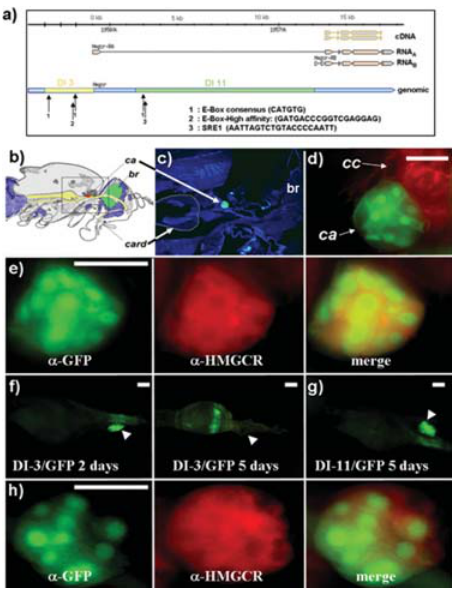
Figure 3. Genesis and expression pattern of the two transgenic p[hmgcr-GAL4] lines. a) Promoters and genomic regions of hmgcr gene. Two mRNAs are transcribed (mRNA A and mRNA B ) under the control of two distinct promoter regions. After splicing, the encoding regions of the two cDNA are identical. A computer analysis of the genomic DNA region has allowed to find two E-Box consensus sequences (CATGTG) [63] localized at 2 3194 to 2 3188 and 2 1315 to 2 1309, and one E-Box High affinity (GATGACCCGGTCGAGGAG) [64] localized at 2 2051 to 2 2033, comprised in a region of 3,8 kb just upstream of the first exon of hmgcr . We then hypothesized that this region could control the RNA A transcription, and cloned and used it to generate the p[DI-3-GAL4] (DI-3) line. To generate the p[DI-11-GAL4] (DI-11) line, we cloned a fragment of 10,6 kb of the first intron ( + 2733 to + 13525) in which we found an E-box consensus [63] ( + 2911 to + 2916) and one SRE1 (AATTAGTCTGTACCCCAATT) [64] ( + 3551 to + 3570). We hypothesized that this region could control the RNA B transcription. b) Schematic lateral view of the head and thorax of Drosophila . card: cardia ; ca : corpus allatum ; br: brain. c–h) The two p[DI-GAL4] lines (DI-3 and DI-11) drive the expression of GFP in the ca . c) At low magnification (10X), the ca , in green, is detected by using primary antibodies against GFP and secondary antibodies labeled with FITC (green) in flies DI-3/ GFP. The background is artificially colored in blue. d) The corpus cardiacum ( cc ) is a structure located near the ca . To confirm that the GFP is expressed in the ca , the corpus cardiacum ( cc ) was stained using an anti-AKH antibody [56] directly conjugated to the rhodamine (red). Thus, we can visualize the ca in green and the cc in red. e) The GFP (left, green) and HMGCR (middle, red) are detected with primary and secondary antibody. Those last are labeled respectively with FITC (green) or Cy3 (red). When merged, we can see that the GFP and HMGCR are colocalized (right panel: yellow), confirming that the DI-3 drives the GFP in the same cells of the ca that express the HMGCR. f) Dissection of the cardia and the ca from DI-3/UAS- gfp flies of different ages and observed directly under a binocular lamp fit with a green fluorescent filter (Leica, MZ FLIII). The GFP is driven by DI-3 in the ca in a temporal dynamic pattern. In two days old adult flies (left panel), the GFP is well detectable in the ca (arrowhead), but not anymore in 5 days old flies (right panel). However, in 5 days old flies, the GFP is detectable in a thin layer of the cardia . g) Dissection of cardia and ca from (DI-11/ UAS- gfp ) directly observed under a binocular lamp fit with a green fluorescent filter (Leica, MZ FLIII). DI-11 also drives the expression of GFP in the ca (arrowhead), and this expression is permanent in adult flies. h) GFP (left) and HMGCR (middle) are detected respectively with primary antibodies against GFP and HMGCR and revealed with secondary antibodies respectively labeled with FITC (green) and Cy3 (red). When merged, we can see that the GFP and HMGCR are colocalized (right panel: yellow), confirming that the DI-11 drives the GFP in the same cells of the ca that express the HMGCR. Scale bar=25 m m.